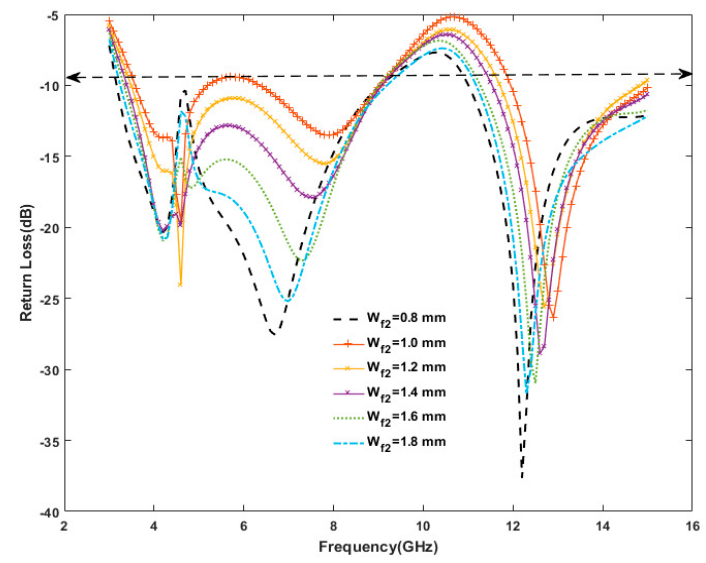
Figure 3. Study of variation on W f2 of textile antenna on the basis of return loss plot.